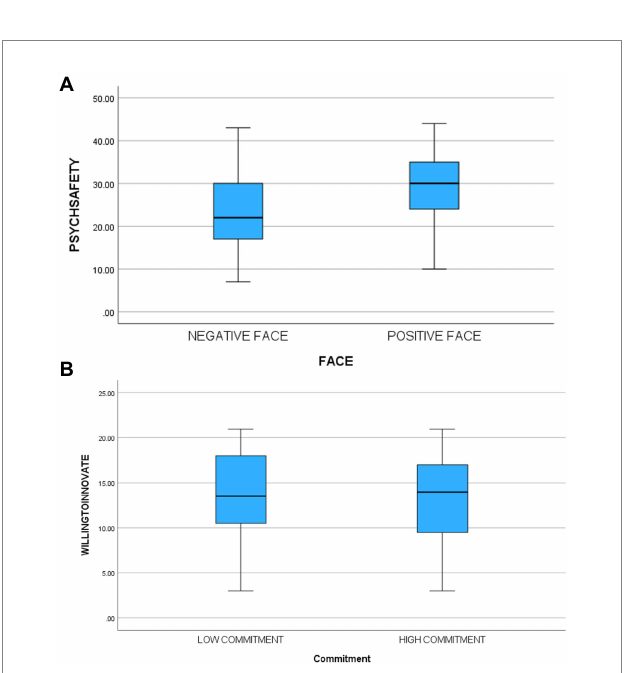
Face-sensitive; low commitment